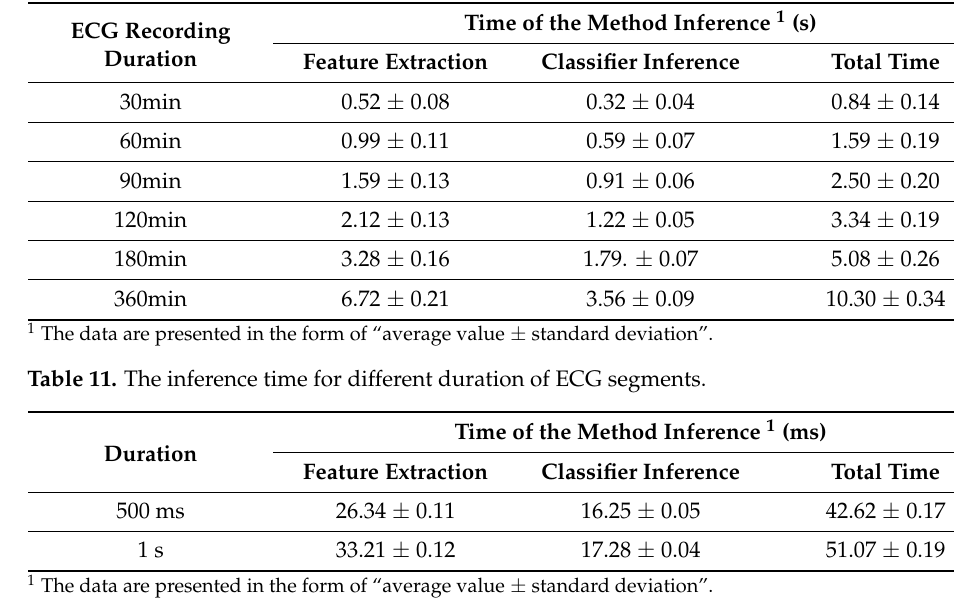
Table 10. The inference time for different duration of input signals.